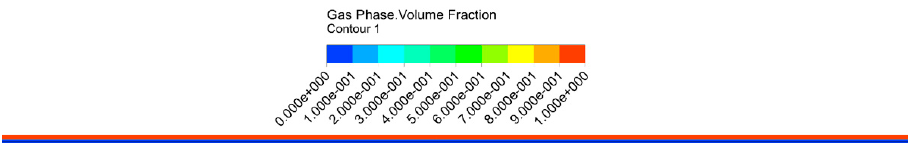
Figure 7. Initial distribution of phase concentrations.